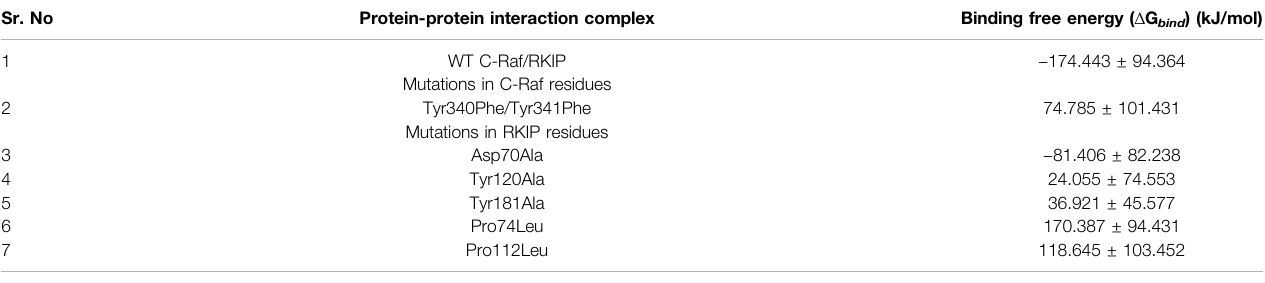
TABLE 5 | Per-residue energy contribution of fi ve critical residues obtained through HawkDock MM/GBSA analysis for equilibrated simulation trajectory of C-Raf/RKIP structural complex. C-raf RKIP Residues